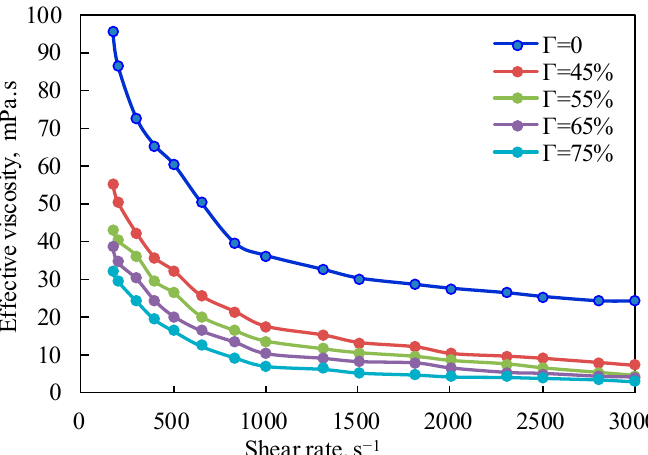
Figure 2. Variation curve of effective viscosity with shear rate (foamed, T = 65 °C).